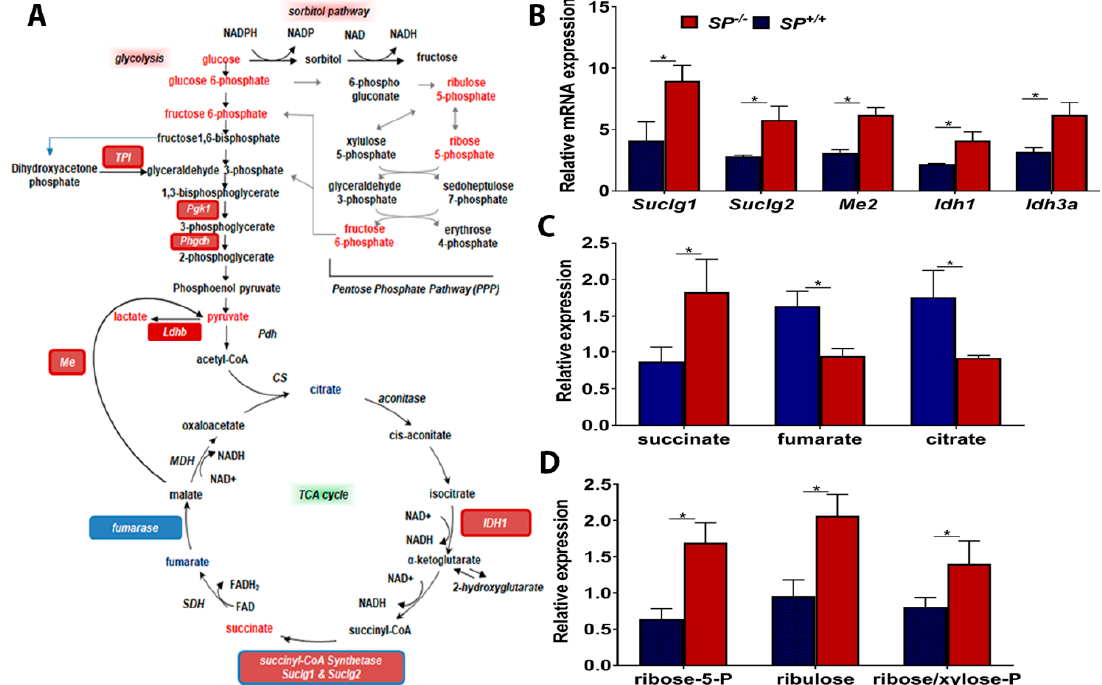
Figure 4. Effect of stromal-SPARC on TCA cycle and pentose phosphate pathway (PPP). ( A ) Schema of glysolysis, TCA and PPP pathways showing the upregulated (Red) and the downregulated (blue) enzymes and metabolites. ( B ) Bar graph representing mean ± SEM of the changes in the transcripts (n = 3/genotype), and ( C ) metabolites (n = 6/genotype) between ID8 tumors grown in SP − / − and SP +/+ mice. ( D ) Bar graph representing mean ± SEM of metabolites of PPP (n = 6/genotype) in syngeneic tumors. * p < 0.05, Student’s t -test.